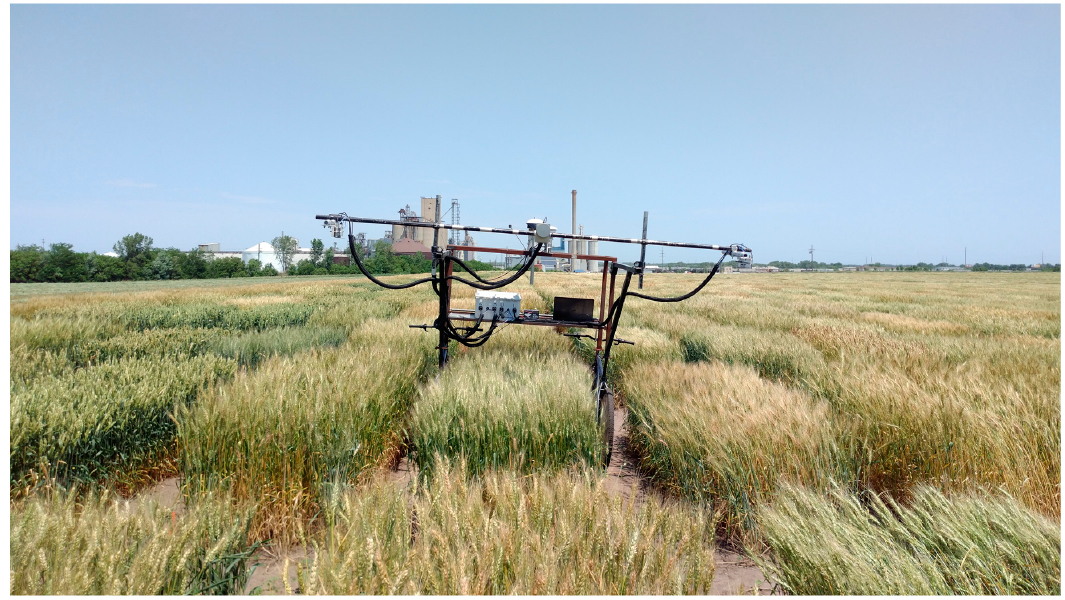
Figure 6. The slanting issue of the phenocart.